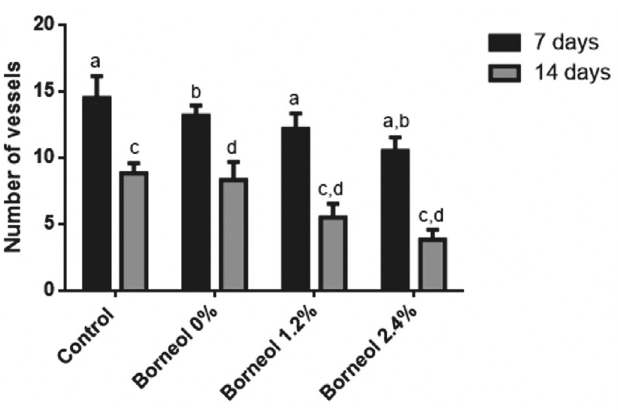
FIGURE 6 - Vessel count according to group and day of experimentation on anti-inflammatory activity test of oral gel containing different concentrations of borneol. a p<0.05: Control